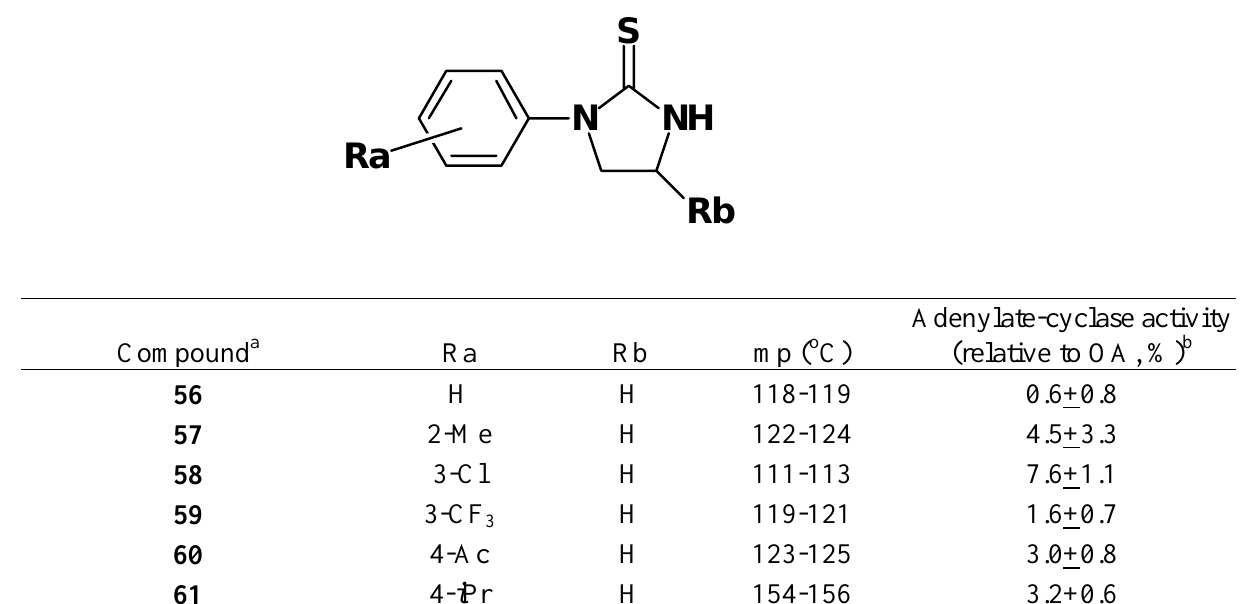
Table 2. OA agonist AITs used in this